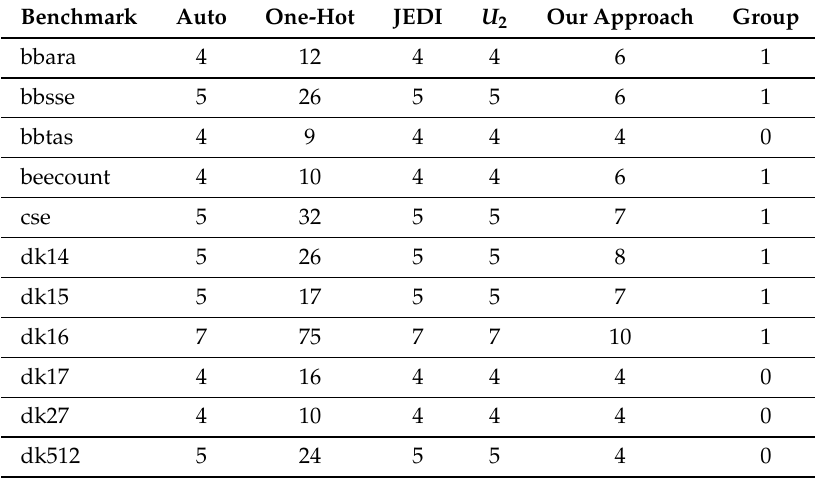
Table 15. Results of experiments (FFs